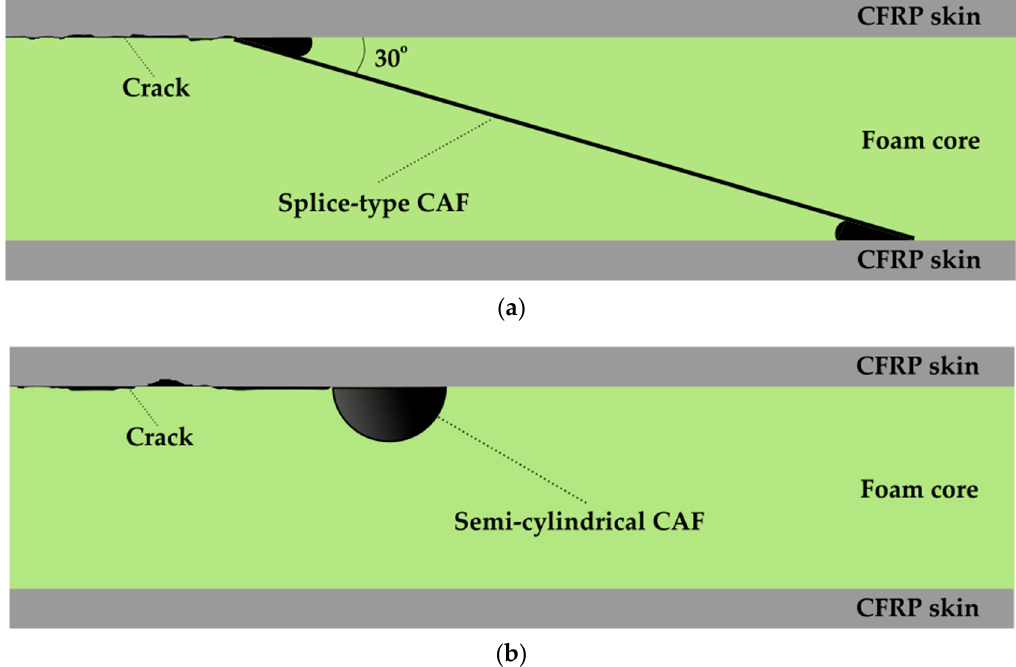
Figure 11. The concept of ( a ) splice-type CAF in foam-core sandwich panels; ( b ) semicylindrical CAF in foam-core panels.